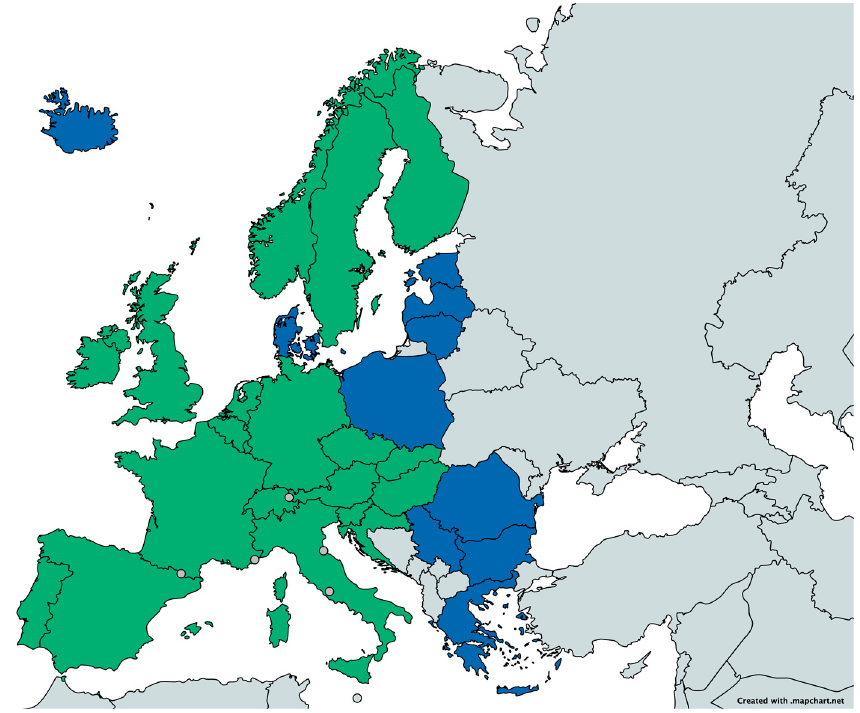
Figure 1. Map of the 20 HERCA member countries (in green) that provided information on the implementation of EU-BSS on radon in workplaces. Other HERCA member countries are in blue.